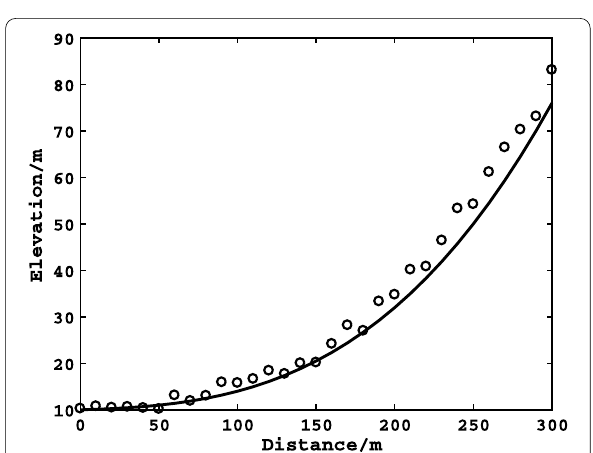
Fig. 4 Elevations of the ground elevation points before and after disturbance by MAAMREs in the first example